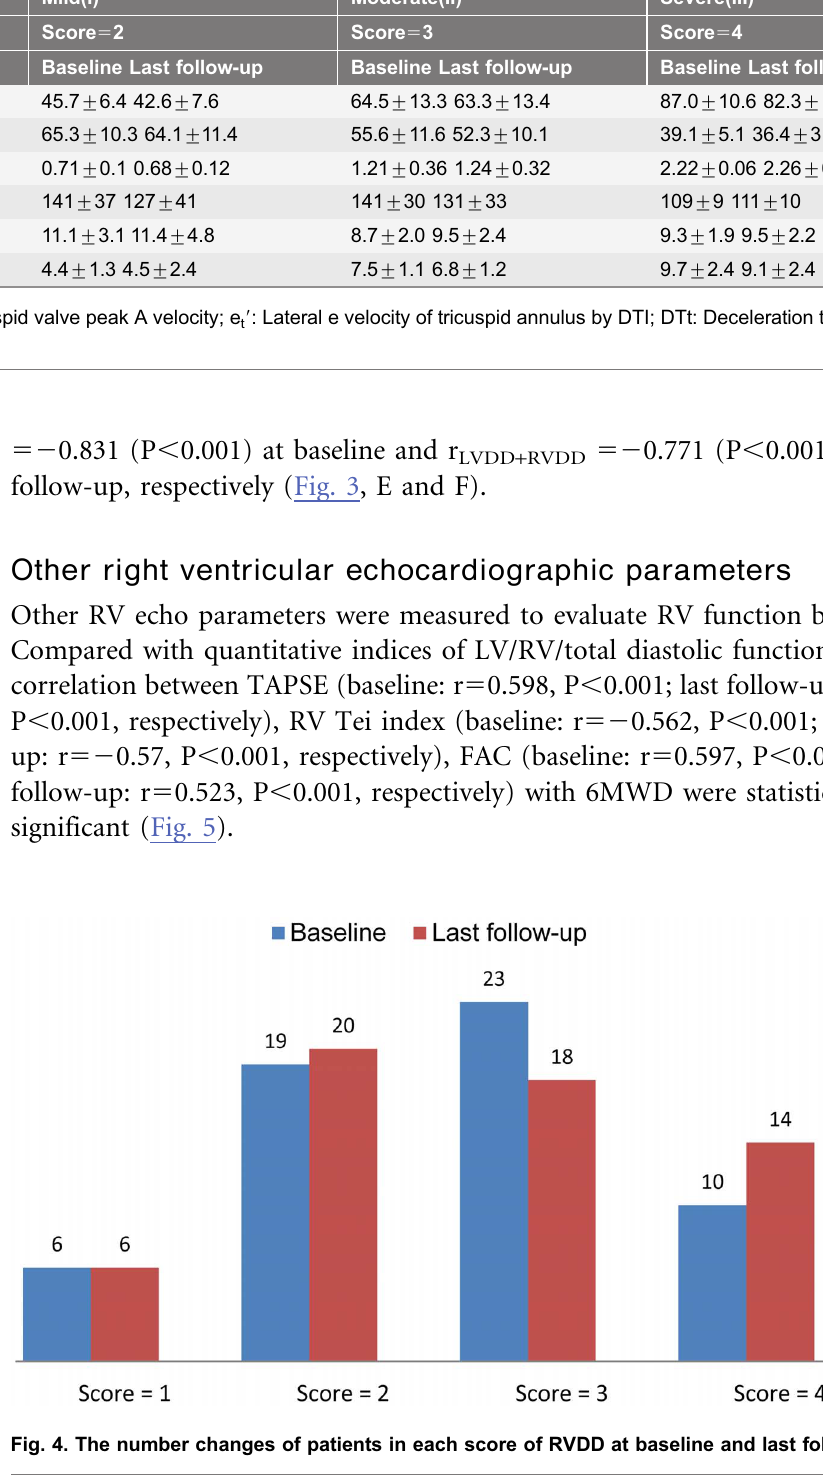
Fig. 4. The number changes of patients in each score of RVDD at baseline and last follow-up.